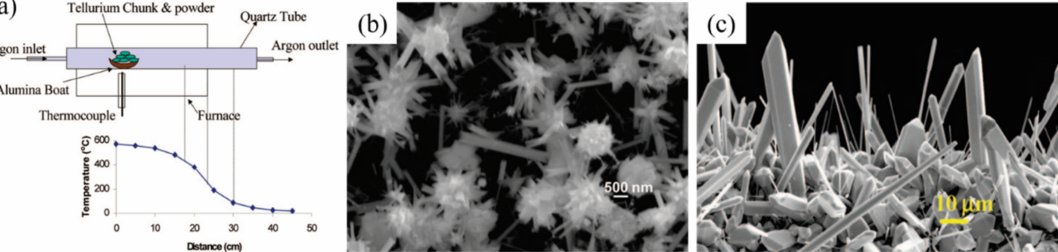
Figure 3. ( a ) Schematic diagram of experimental device for preparation of Te nanotubes by physical vapor deposition shows gas flow arrangement in tubular furnace. Different temperature zone in the furnace along the flow of the gas is also shown. ( b ) SEM of Te nanotubes growing radially from Te sphere in the temperature zone of 200 ◦ C. ( c ) SEM image of Te microrods grown in the temperature zone of 400–350 ◦ C. Reprinted with permission from [31]. Copyright 2008, American Chemical Society, Washington, DC, United